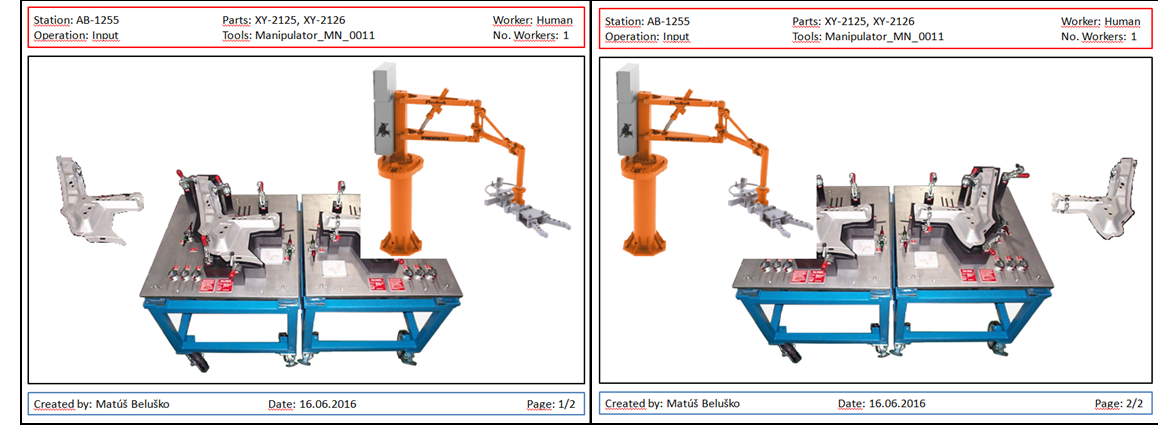
Figure 11: Instruction after splitting into two steps.